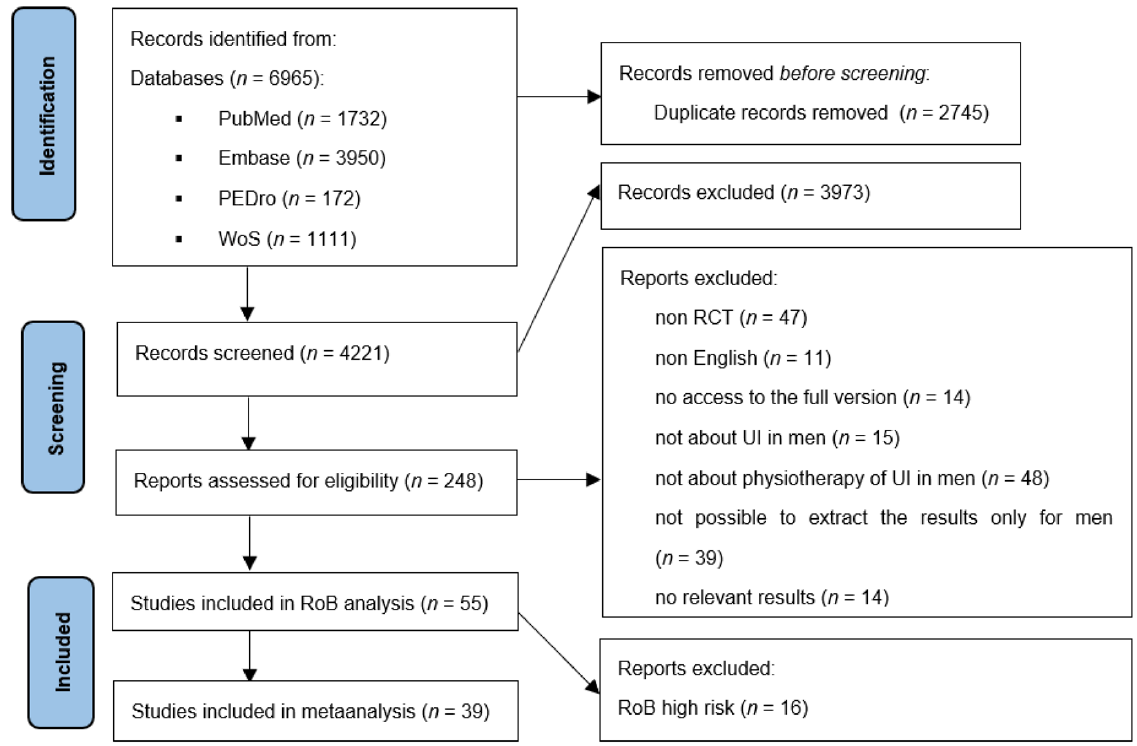
Figure 1. PRISMA flow diagram of selection